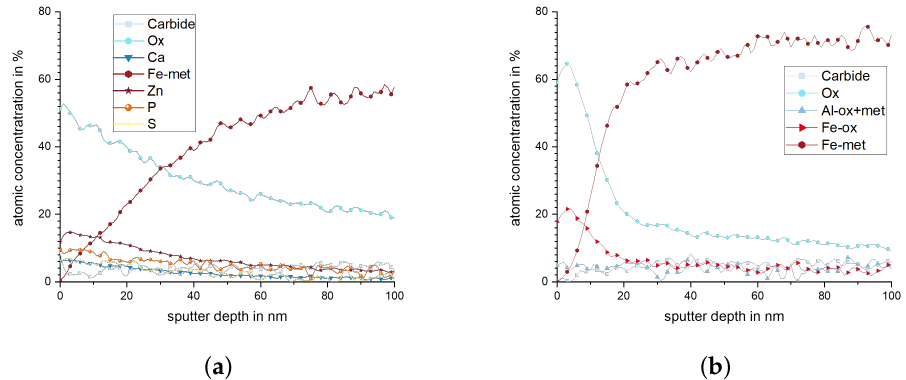
Figure 15. Chemical composition of elements with more than 4% atomic concentration (measured by XPS) of disk after wear test against a 10.4% Si FS pin ( a ) on worn area and ( b ) in